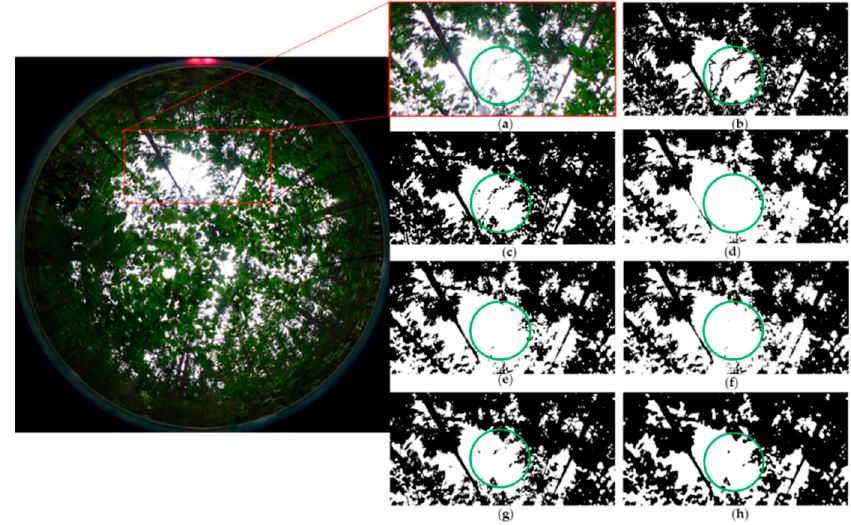
Figure 9. Local detail comparison of a mixed forest canopy (small foliage in the green circles under heavy sunlight). ( a ) Original CHP images; ( b ) manually extracted reference images, segmentation results obtained from ( c ) newly developed U-net method as well as from ( d ) Otsu; ( e ) Ridler; ( f ) fuzzy clustering method (FCM); ( g ) WinSCANOPY; ( h ) Habitat-Net methods.